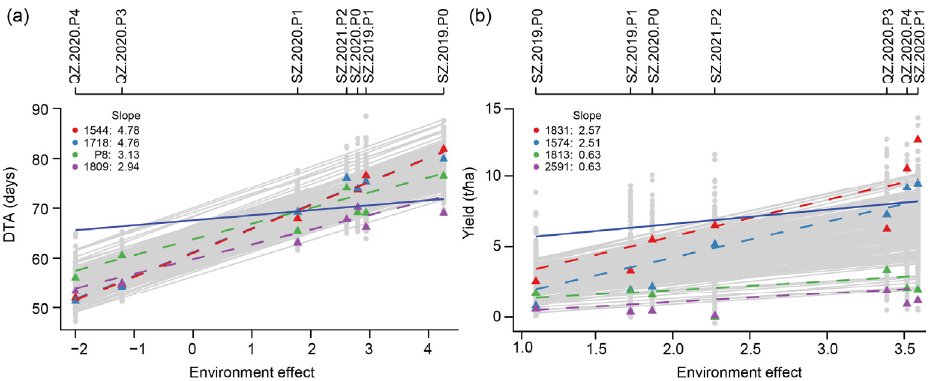
Figure 3. Environment effect and genotype plasticity. Finlay–Wilkinson regression analysis for ( a ) DTA and ( b ) yield. Only the four lines with the two highest and lowest linear plasticity values for the trait are shown. The dashed lines represent the slope (linear plasticity) of individual genotypes; the greater the slope, the greater the linear plasticity of the plant. The solid blue line represents a slope of one.